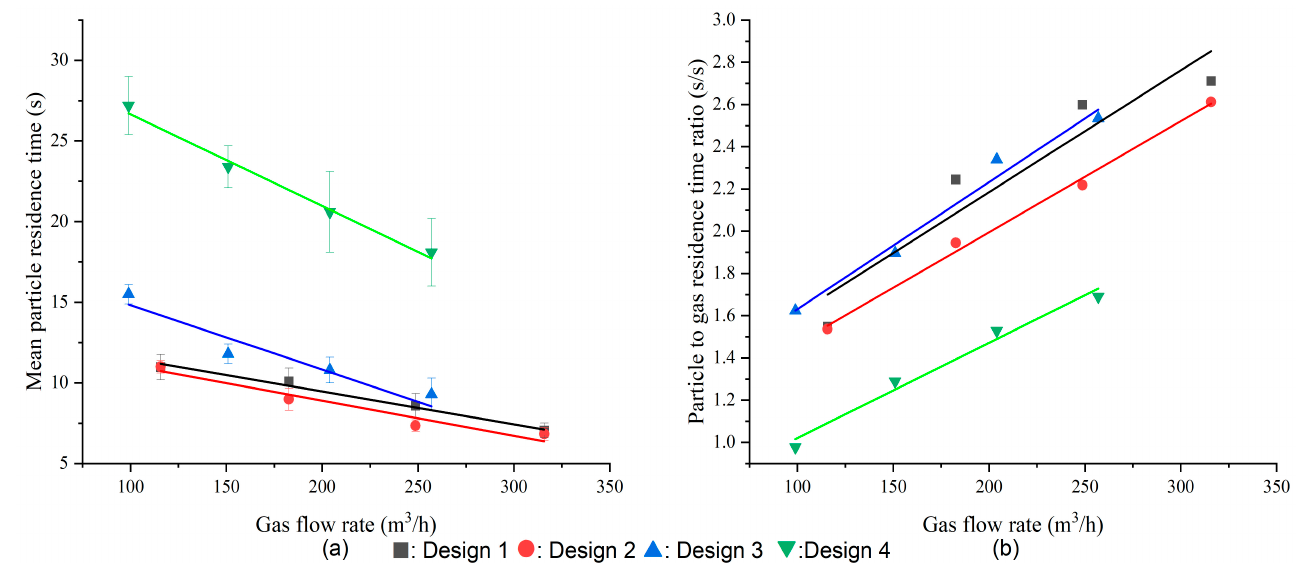
Figure 5. Mean particle residence time ( τ ) and ratios between particle and gas residence time for different configurations and gas flow rates ( a ) mean particle residence time ( b ) particle to gas residence time ratio.